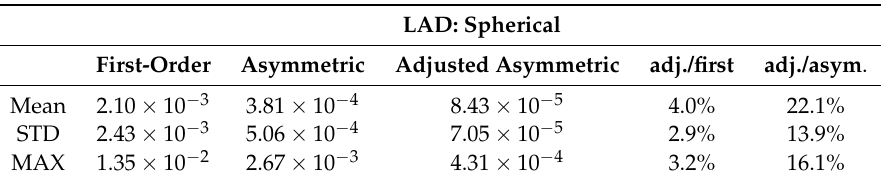
Table 3. Statistics of the errors in first-order, asymmetric-order, and adjusted asymmetric-order ( k opt = 1.29) isoline equations. LAD: Spherical First-Order Asymmetric Adjusted Asymmetric adj./first adj./asym